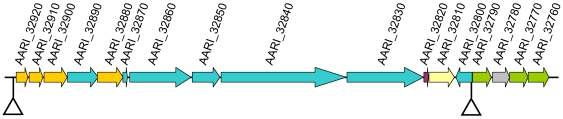
Catechol-type siderophore gene cluster in A. arilaitensis Re117.Genes are coloured as categorized: non-ribosomal siderophore peptide synthetase components and accessory proteins in blue, other siderophore biosynthesis proteins in orange, MbtH-like protein in dark purple, siderophore exporter in yellow, Fe3+/siderophore transport components in green and siderophore-interacting protein in grey. Triangles indicate the presence of putative IdeR (iron-dependent regulator) binding sites.